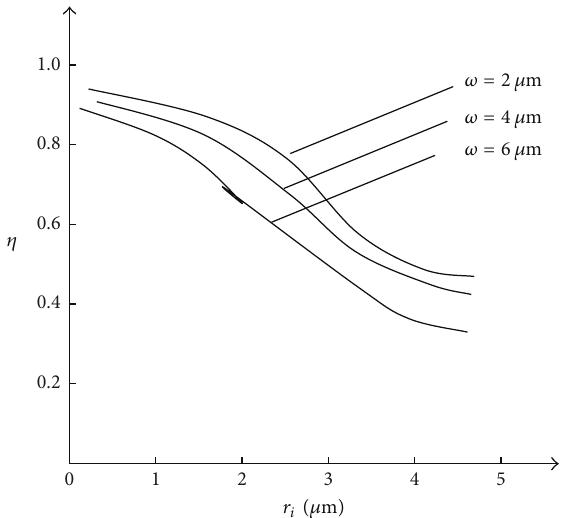
Figure 5: The theoretical coupling efficiency of the new fiber